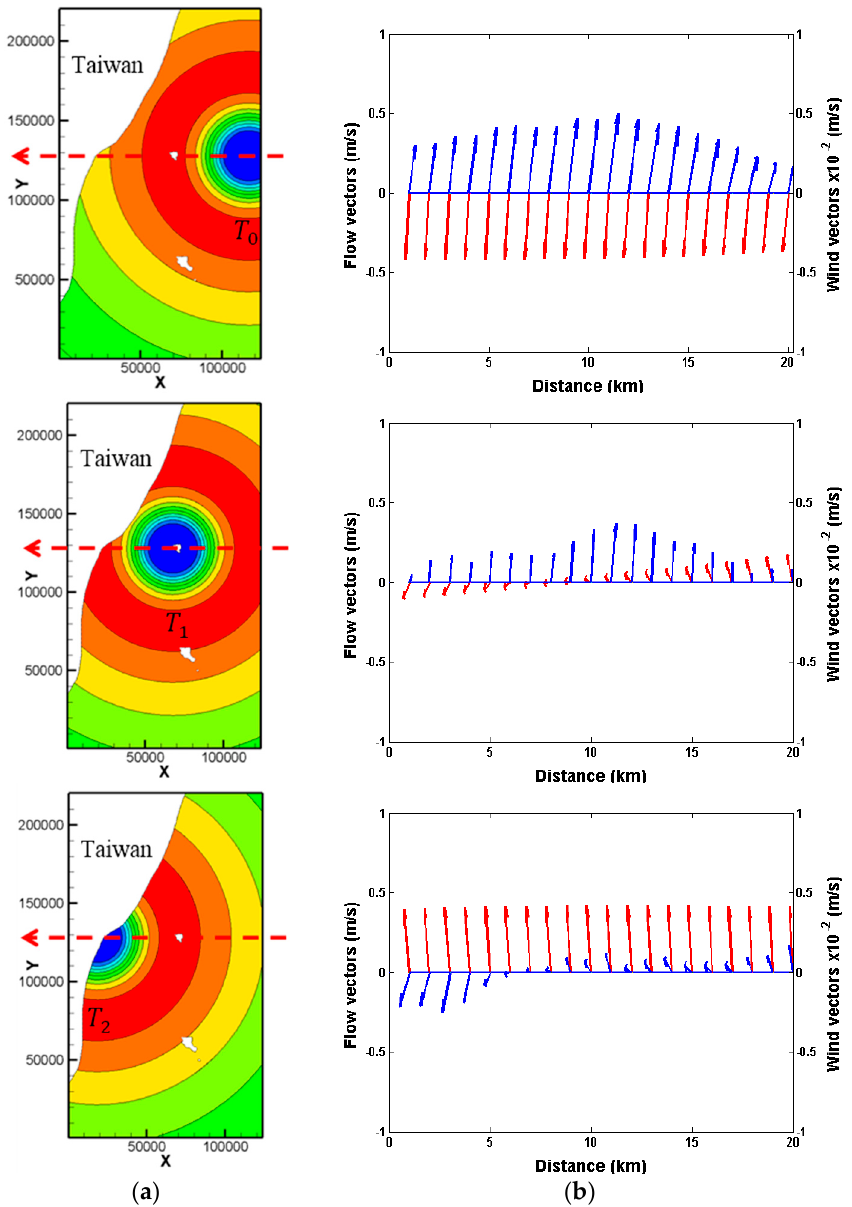
Figure 15. ( a ) W 10 -contours and ( b ) wind vectors (red) and flow vectors (blue) of EW typhoon along cross section Q 0 Q 1 with moving speed W T = 2.5 m/s at T 0 – T 2 three time instances indicated by the three vertical lines of Figure 16a.